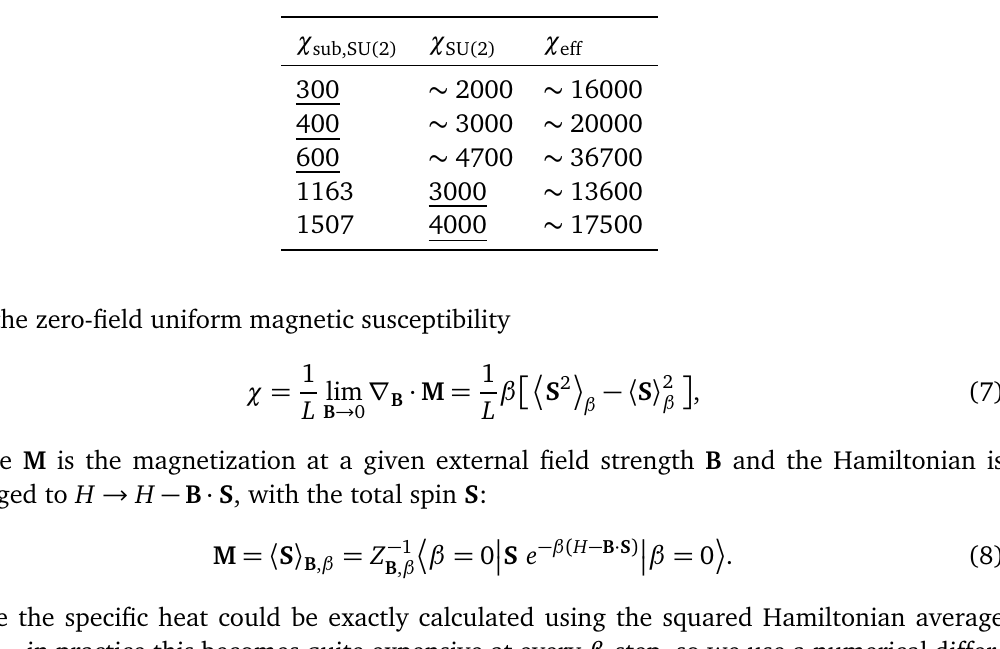
Table 3: Parameters of the thermodynamic calculations. For an explanation of the bond dimensions, see Tab. 1. The underlined values were